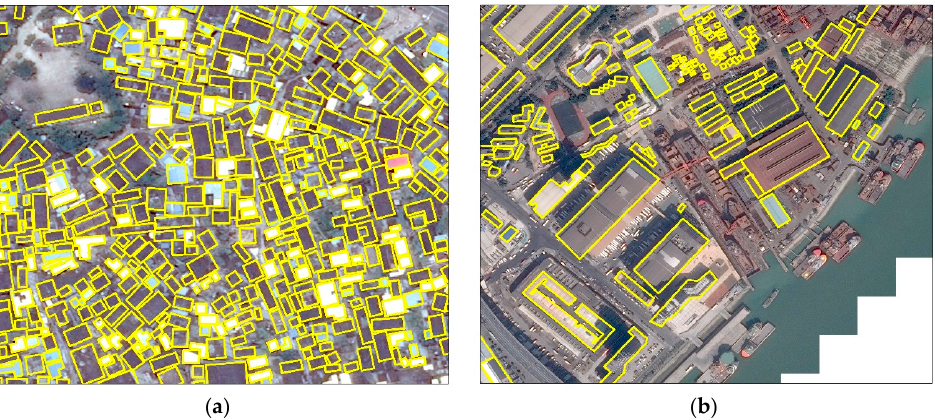
Figure 10. Various Building samples under complex backgrounds. ( a ) Building samples under complex background. There are streets, trees, bare land around these buildings, and the buildings are closely located to each other. ( b ) Building samples which are easily confused with ships in the same image. The ships have similar size, texture and shape to buildings.